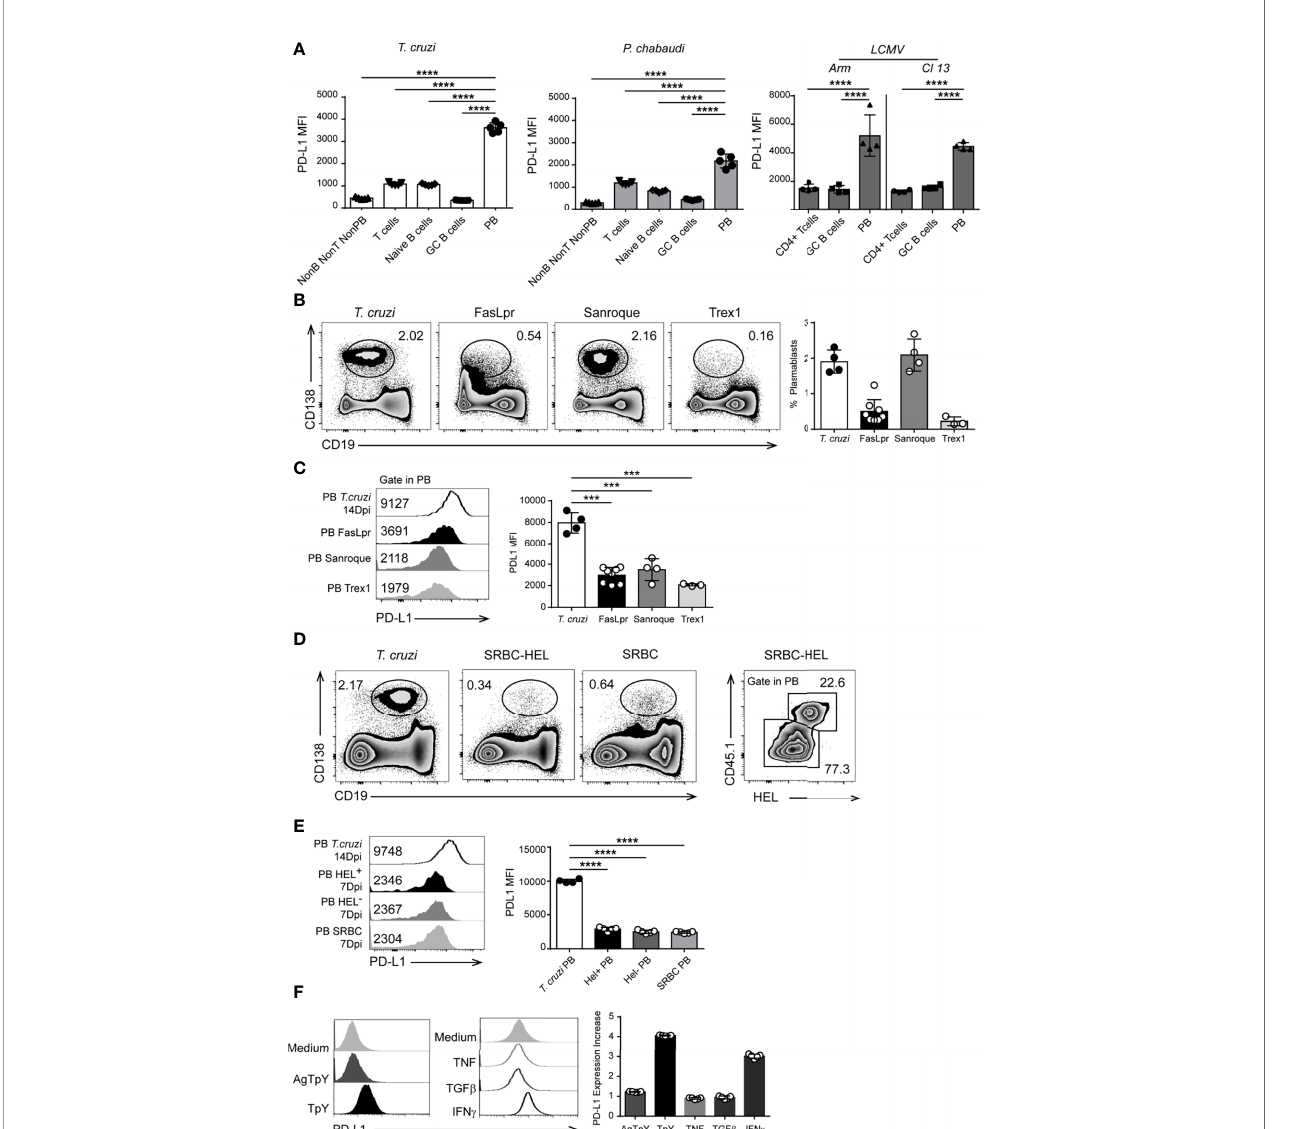
FIGURE 3 | PD-L1 hi plasmablasts were present in infected but not in autoimmune mice. (A) Statistical analysis of MFI of PD-L1 on Non-B non-T non-PB cells (CD3 - CD19 - B220 - CD138 - ), T cells (CD3 + CD19 - B220 - ), naïve B cells (CD19 + CD3 - CD138 - B220 + IgD + CD38 + Bcl6 - ), GC B cells (CD19 + CD3 - CD138 - B220 + CD38 low Bcl6 + ) and plasmablasts (PB, CD19 int CD138 + ) from the spleen of T. cruzi- infected mice (n=5) obtained at 14 Dpi, or from the spleen of P. chabaudi -infected mice obtained at 10 Dpi (n=5); or CD4+ T cells, GC B cells, and PB from the spleen of Arm- or Cl13 LCMV-infected mice obtained at 9 Dpi (n = 4 for each LCMV infection). ****p<0.0001, one-way ANOVA, Bonferroni post hoc test. (B) Representative fl ow cytometry plots and statistical analysis of the percentage of splenic plasmablasts from T. cruzi-infected- and from FasLpr, Sanroque and Trex1 mice. C57BL6 mice (n = 4) were infected with T. cruzi Y strain, and the spleens were obtained at